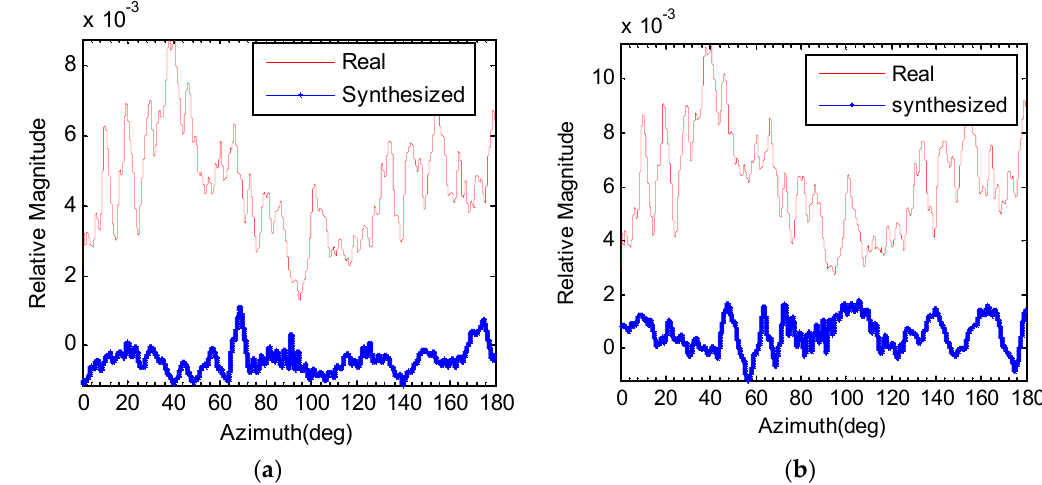
Figure 21. ( a ) Fluctuation intensity difference comparison of Figure 18; ( b ) STD difference comparison of Figure 19.